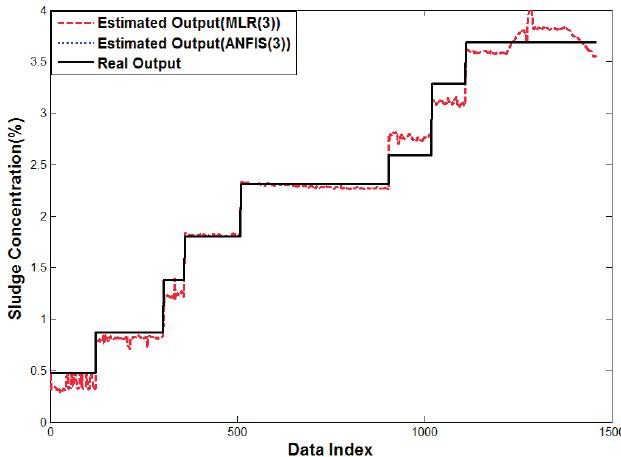
Figure 14. Performance curve of Methods 4 and